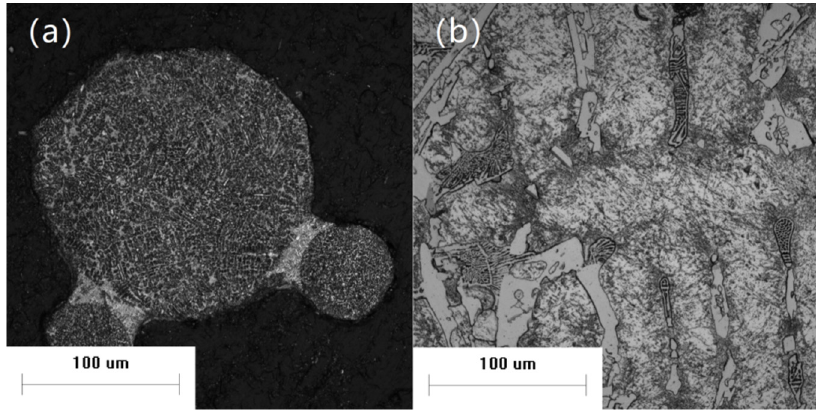
Figure 7. Microstructure of the ( a ) powder compared with that of the ( b ) ingot.